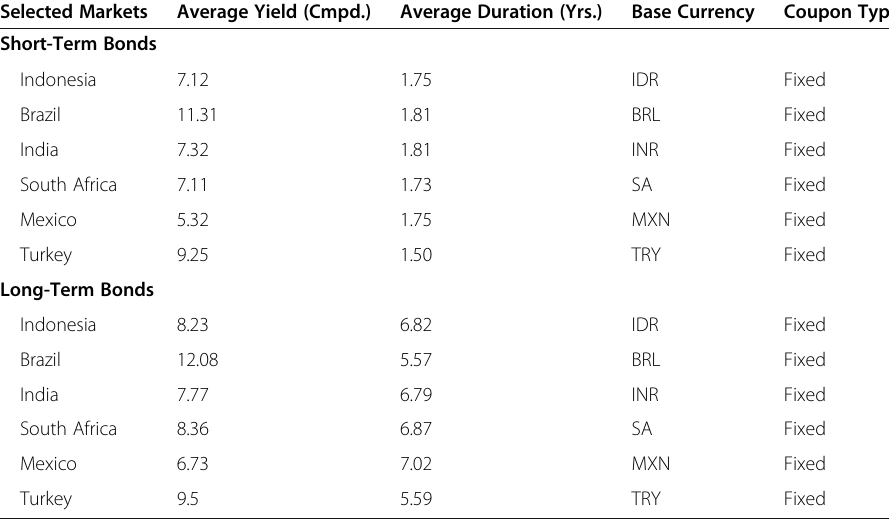
Table 1 Basic features of the selected bonds Selected Markets Average Yield